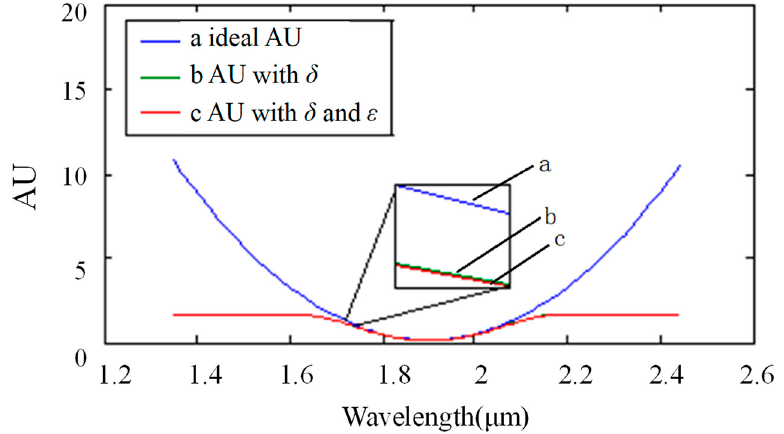
Figure 7. Result of stray light on the absorption spectrum in single-stripe mode: the horizontal ordinate shows the wavelength with units of micrometers. The longitudinal coordinate shows ab-